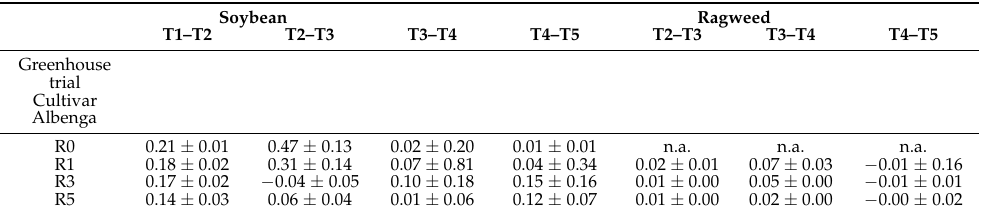
Table 2. Growth rate of soybean and ragweed (g/d; mean ± standard deviation) throughout the growing period (T1–T5), dependent on the ragweed density (0, 1, 3, 5 plants: R0, R1, R3, and R5) and cultivar; n = 4; significance levels: * p < 0.05, ** p < 0.01, *** p <